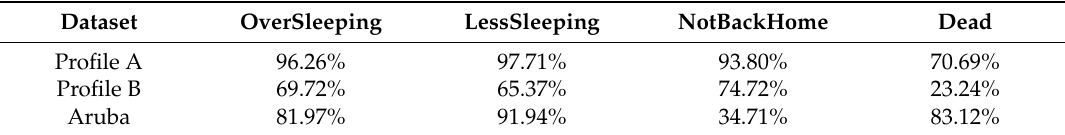
Table 9. Classification of abnormal behaviour